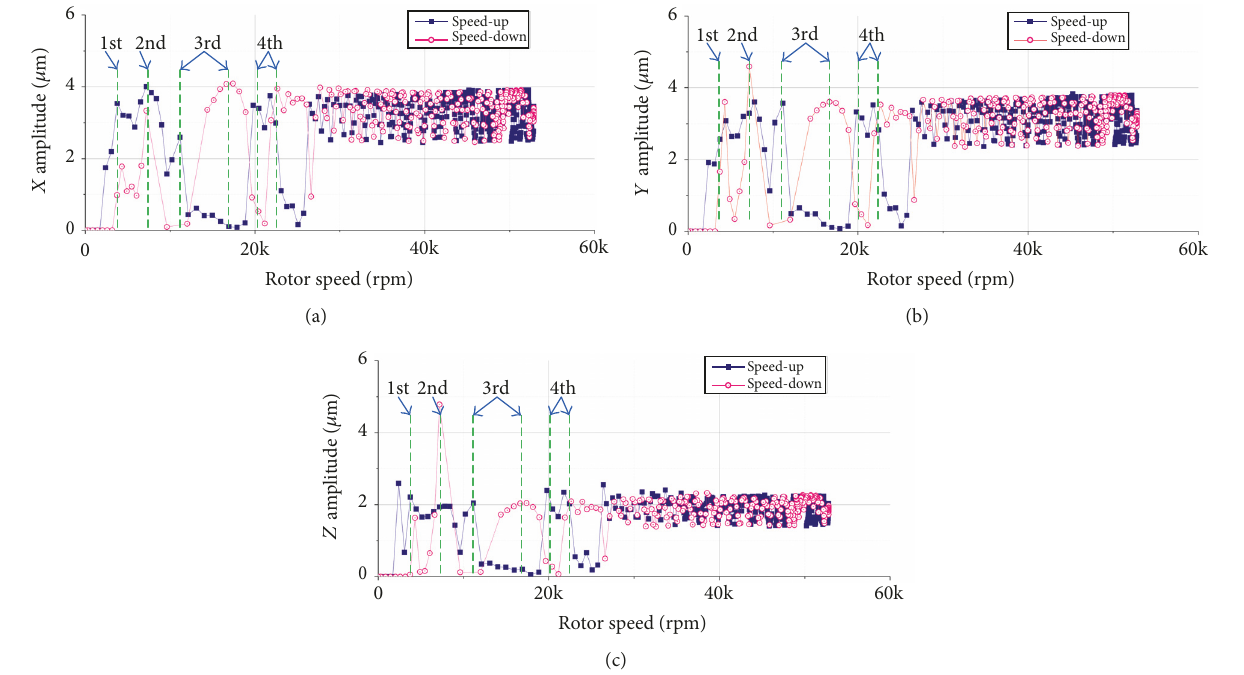
Figure 13: Vibration amplitude of the high speed rotor at main frequencies in the speed-up and coast-down process: (a) 𝑋 direction; (b) 𝑌 direction; (c) 𝑍